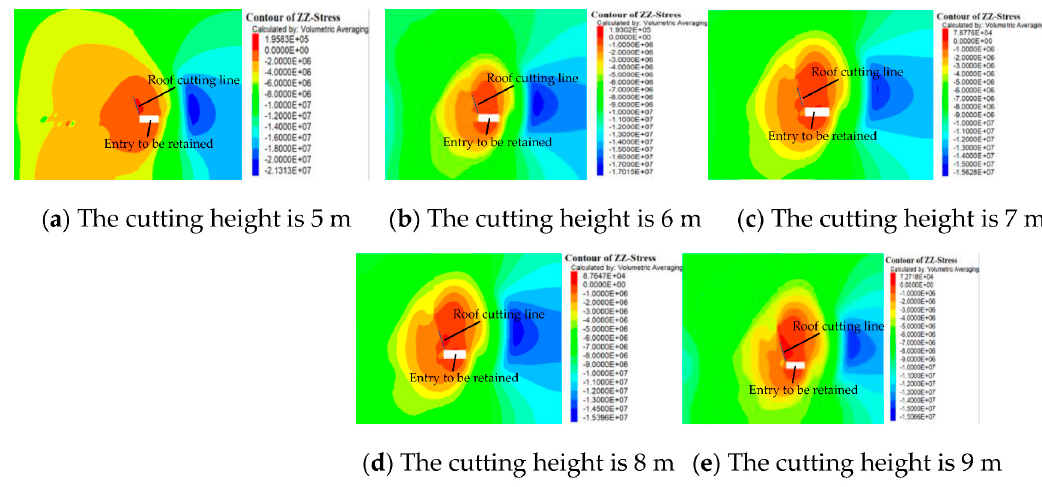
Figure 6. Vertical stress distribution of roadway surrounding rock under different cutting heights.